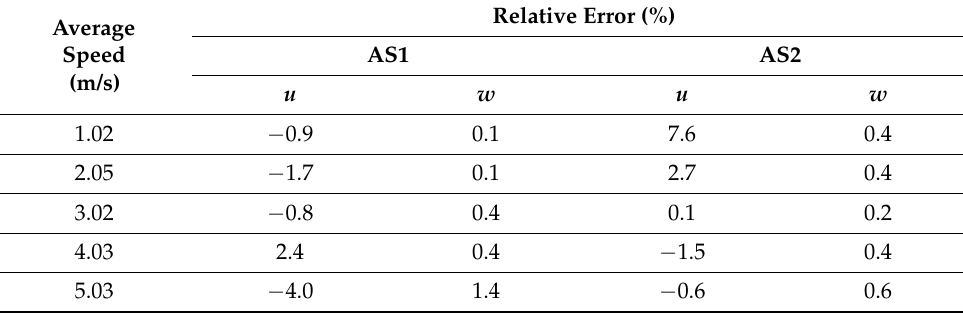
Table 4. Identified spacing errors using the axle